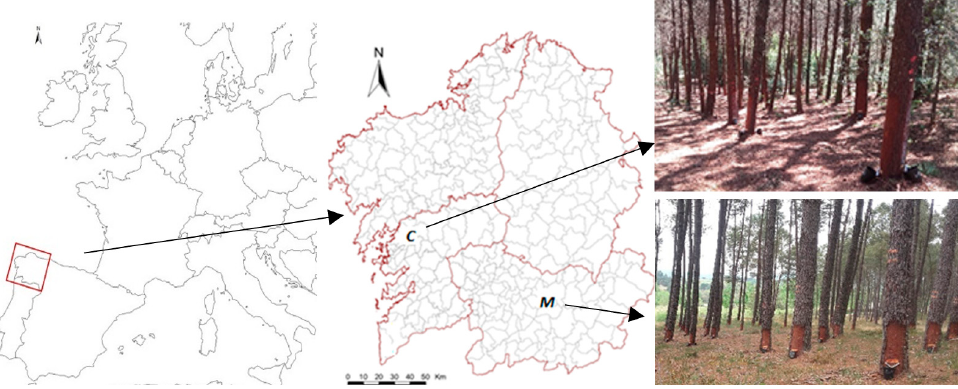
Figure 1. Location of the study plots: Caldas de Reis (C) and Maceda (M). The trials were carried out during a period of three years in both plots: between 2016 and 2018 in the Caldas de Reis plot and between 2017 and 2019 in the Maceda plot. The American tapping method, which consists of cutting grooves in the stem, removing strips of bark and phloem and applying a stimulant paste, was used. Note that the terms groove and wound are used interchangeably in this paper. The resin flow was collected in a semi-rigid “pot” container of approximate capacity 2 kg. The paste used (Cunningham or Brazilian paste) [12] has a lower concentration of sulphuric acid than the pastes conventionally used in the rest of the Iberian Peninsula [13] and in other parts of the world [29]. The time interval between cutting the grooves and the number of grooves varied depending on the year. In the Caldas de Reis plot, 9 grooves were cut in each tree in 2016. In both